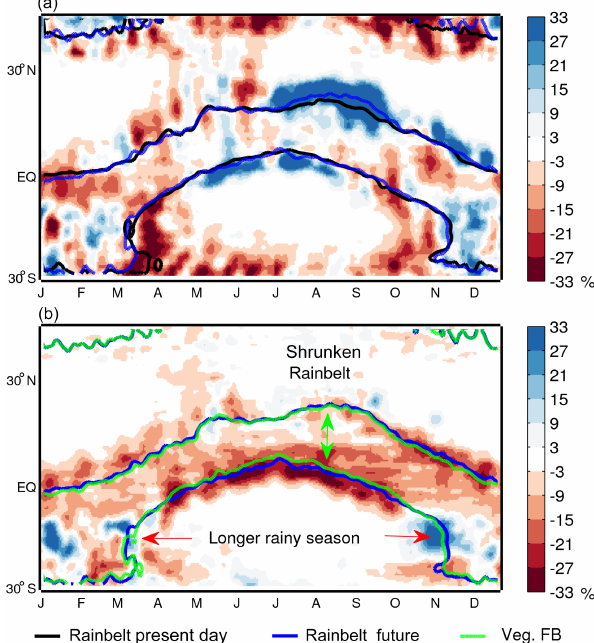
Figure 11. Daily changes in precipitation averaged over the longi- tude band 18–30 ◦ E, represented as relative changes in daily precip- itation intensity (shading, %) and rain belt location (contour) due to (a) climate change and (b) vegetation feedback for future. The rain belt location is defined as a 2mmday − 1 contour. Ten-day running mean is applied for daily